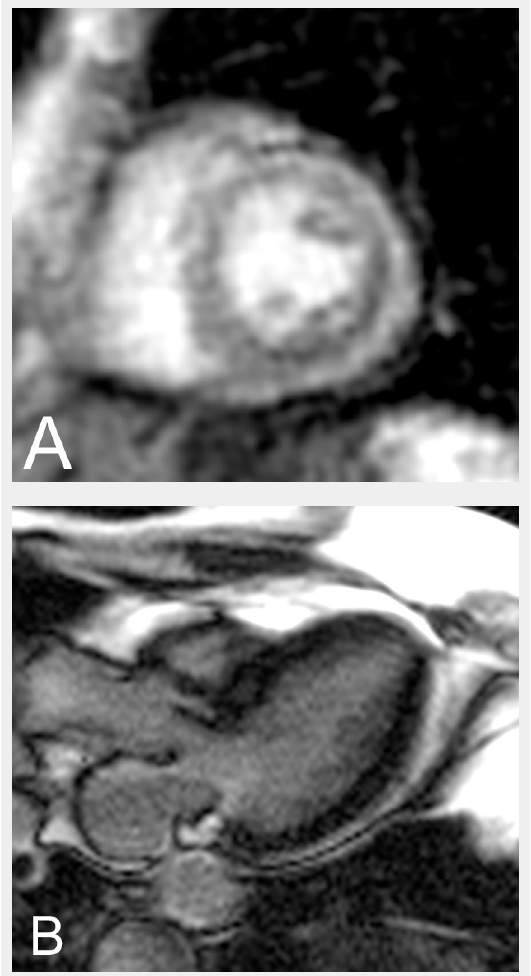
A 12 lead electrocardiogram showing sinus rythm with a heart rate of 86 beats per minute, a borderline 0.1 mV horizontal ST depression in V4-V5 and minors ST abnormalities in V6, II, III and aVF.